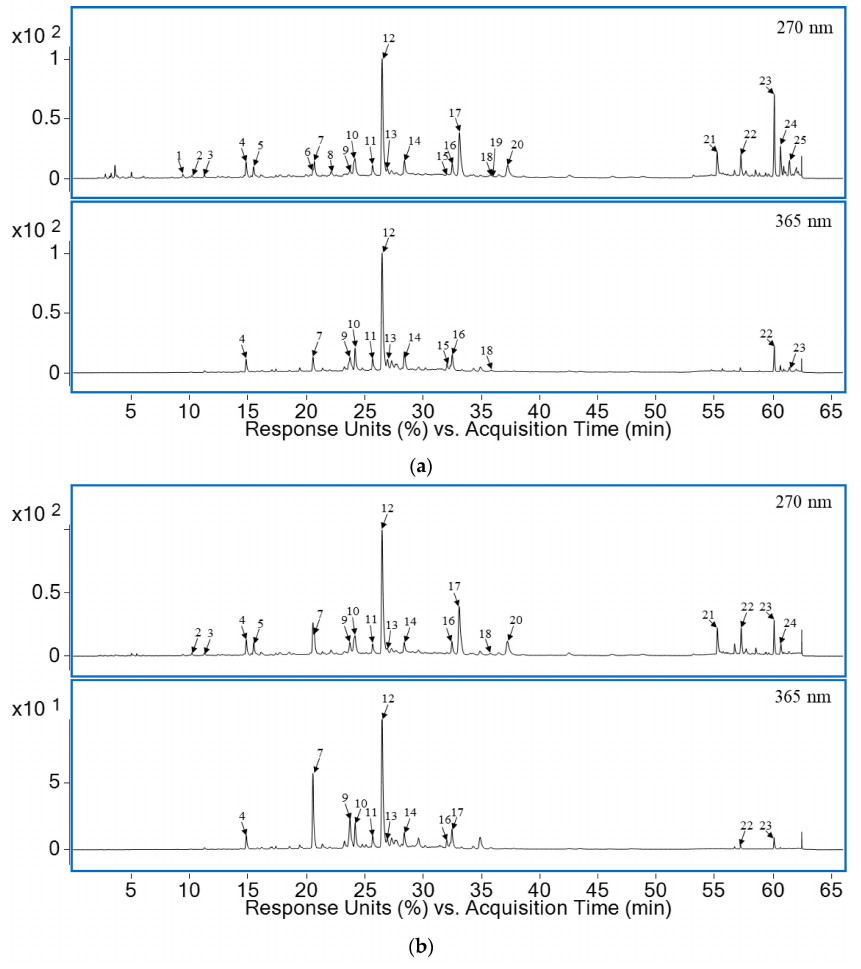
Figure 4. UV chromatograms of ( a ) OPT 1 and ( b ) OPT 2 extracts obtained by LC-PDA-MS. The compound labels are explained in Table